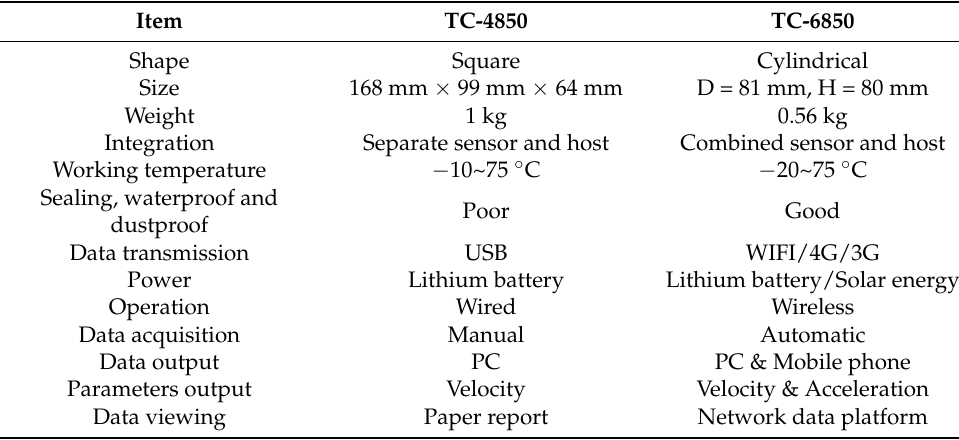
Table 4. Comparison of TC-4850 and